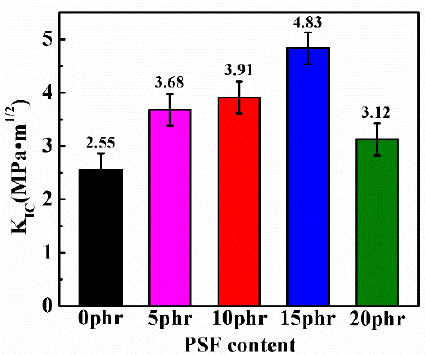
Figure 8. The fracture toughness in terms of critical stress intensity factor ( K IC ) of the PSF/epoxy blends as a function of PSF content.